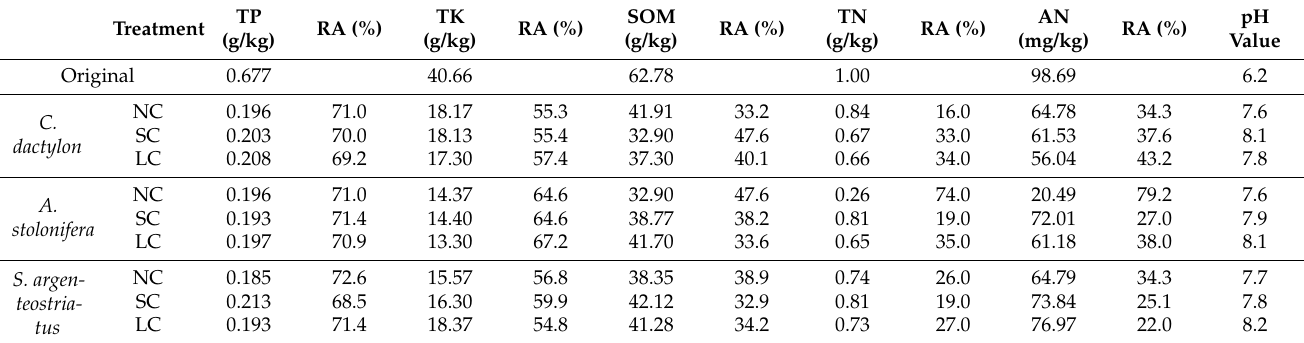
Table 7. Composition of original and after-use